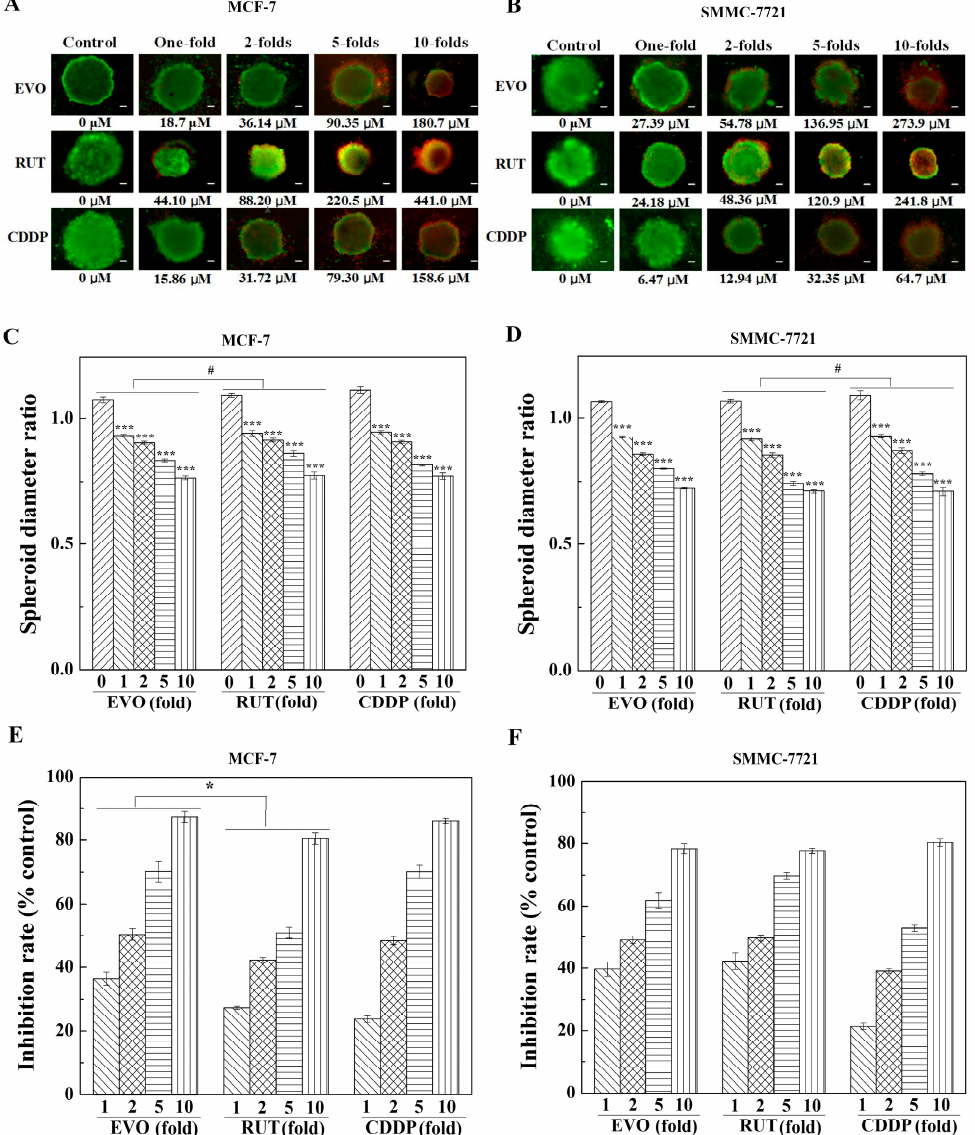
Figure 3. Anti-proliferative effects of the model drugs (EVO, RUT) and control drug (CDDP) on MCF-7 and SMMC-7721 cells in a 3D model. The live/dead images of ( A ) MCF-7 and ( B ) SMMC-7721 spheroids after treatment of different drug concentrations measured. The cell spheroid diameter ratio of ( C ) MCF-7 and ( D ) SMMC-7721 after 48 h treatment of the three drugs at different concentrations. The results are expressed as means ± SD ( n = 6). *** p < 0.001, drugs versus negative control. # p < 0.05. The inhibition rate of the three drugs in ( E ) MCF-7 and ( F ) SMMC-7721 cells in 3D cultures at different concentrations of drug treatment after 48 h incubation. The results are expressed as means ± SD ( n = 6). * p < 0.05. Scale bars, 20 μ m.